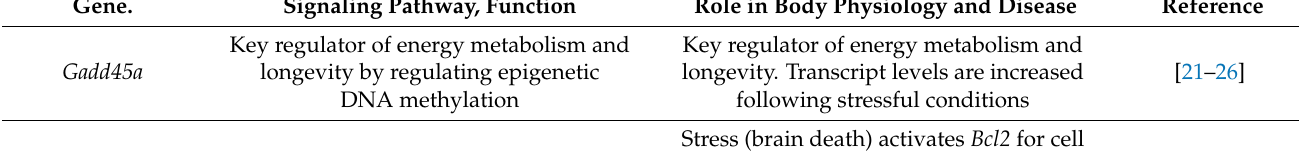
Table 1. Upregulated genes in the brain after death and induced